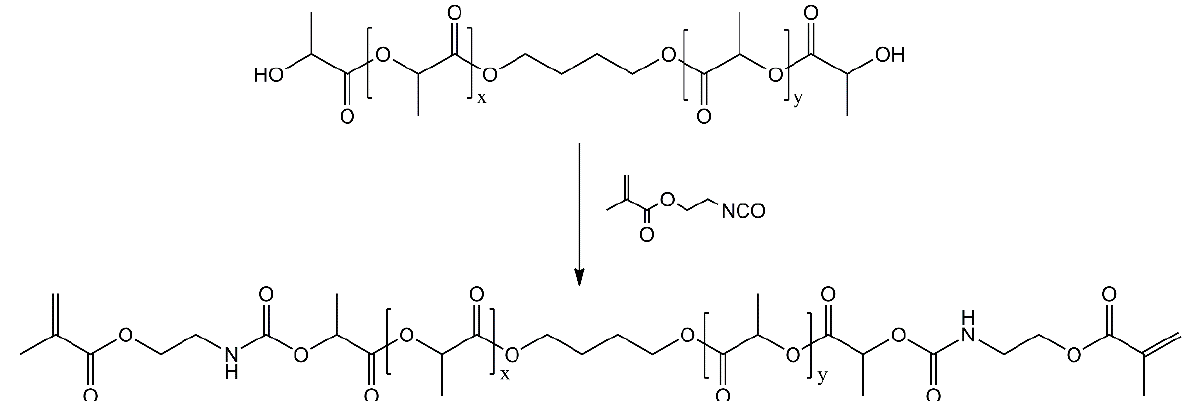
Figure 21. Synthesis route of PLAMA. Table 12. Spectra peaks used to control the synthesis of PLAMA oligomer mixtures.